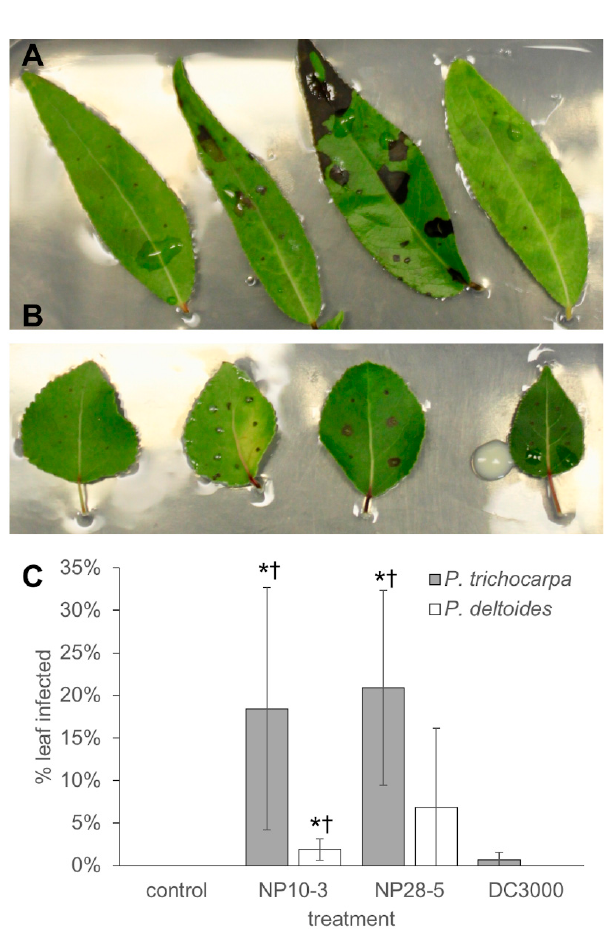
Figure 4. Comparison of Populus susceptibility to P. syringae. Surface-sterilized leaves were wounded six times with a sterile needle and 10 µ L of bacteria (8 × 10 6 cells / mL) was spotted on top of each wound. ( A ) P. trichocarpa Nisqually-1 leaves treated with (left to right) media control (R2A), NP10-3, NP28-5, and DC3000 for 48 h. ( B ) P. deltoides WV94 leaves treated with (left to right) media control, NP10-3, NP28-5, and DC3000 for 48 h. ( C ) Lesion development after 48 h. Error bars, standard deviation of four biological replicates. Grey, lesion development on P. trichocarpa leaves. White, lesion development on P. deltoides leaves. *, p < 0.05 compared to control; †, p < 0.05 compared to DC3000. Differences between NP10-3 and NP28-5 are not significant. Table 4. Scope of pathogenicity of Populus trichocarpa isolates NP10-3 and NP28-5. Pseudomonas syringae pv. tomato DC3000 was used as a comparison.